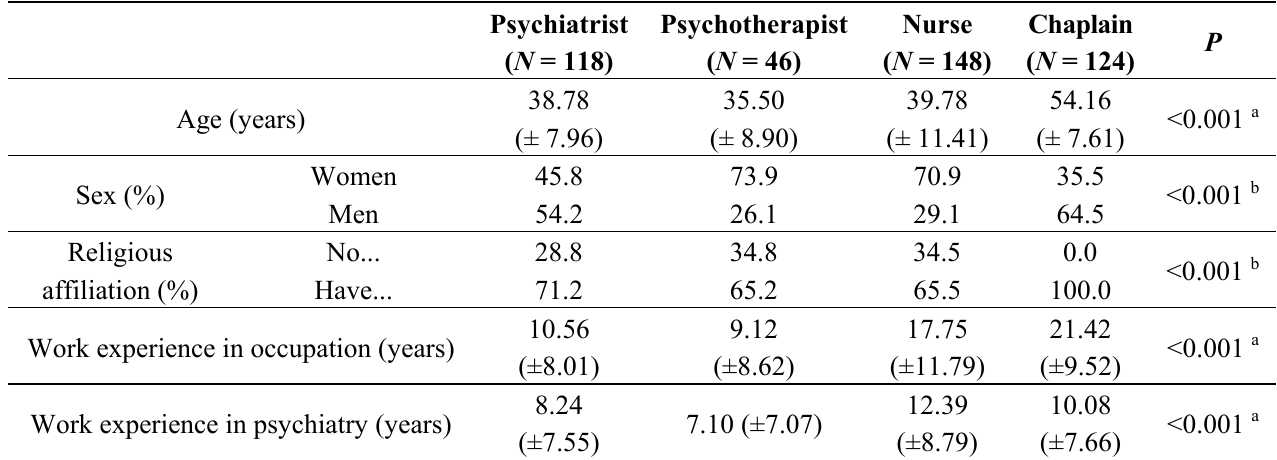
Table 2. Demographic differences between professional